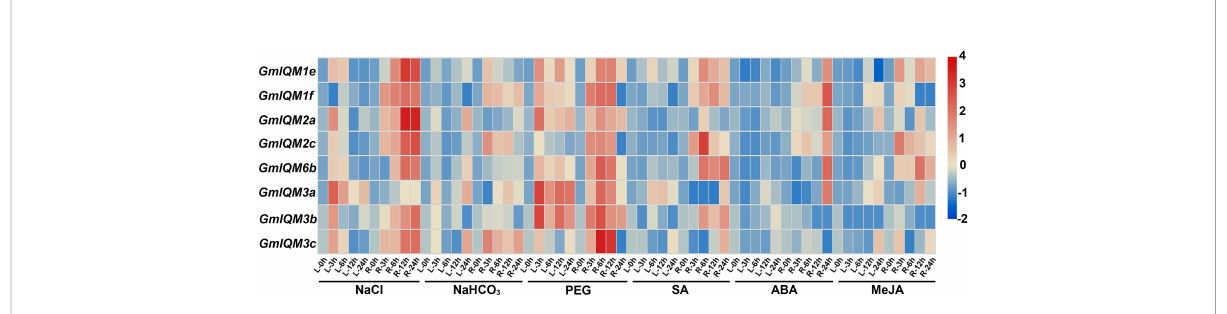
FIGURE 9 Heat map of the expression of GmIQMs in leaves and roots under different treatments.NaCl, NaHCO3, PEG, SA, ABA, and MeJA were used to treat soybean. Total RNA was then extracted from the roots and leaves at indicated times. Each sample was collected from fi ve independent plants, independent biological assays were repeated three times, and similar results were obtained. Data from one representative replicate are shown. Values are means average from three technical measurements. Color scale at the right side of the image represents log10 of the gene expression values. Red indicates high expression level and blue indicates low expression level. L, leaves; and R,